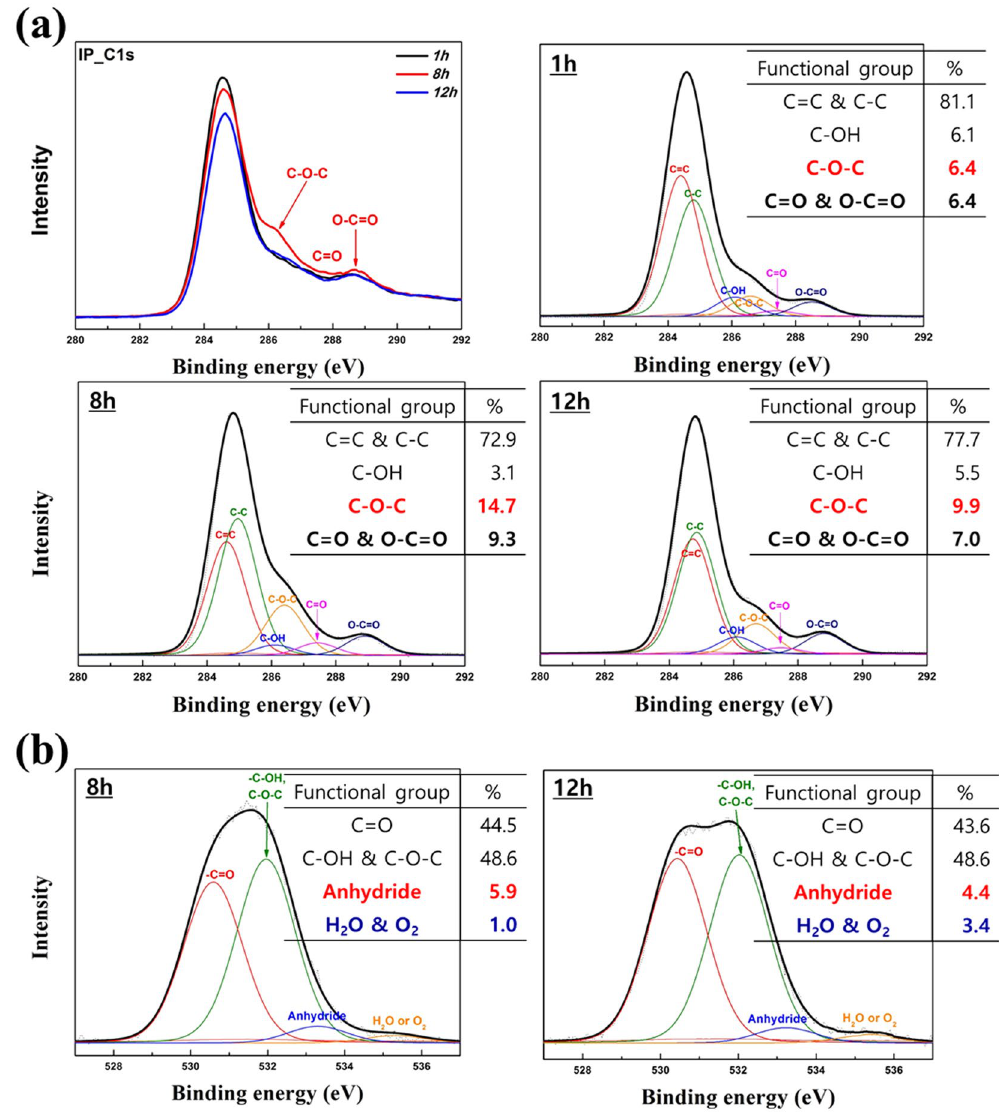
Figure 7. X-ray photoelectron spectra of IP OFs prepared with different oxidation times: ( a ) C1s and ( b ) O1s suggest that proper oxidation times create strong and necessary C-O bonds, whereas the overheating process used with the sIP12 OF generates unnecessary bonding between oxygens, diminishing the significant C-O bonding. It is determined that the O = O bond is lying on a site with weak thermal stability; therefore, the bonding site acts as a defect to destroy the crystal structure after carbonization. Due to the low oxygen content, the differ- ences in the molar ratio distributions of the sMP OFs are relatively lower than those of the sIP OFs (Figure S3). However, they reveal tendencies analogous to the analyzed results of the sIP OFs. Evidence for the weak thermal stability of the bonding between the carbon and oxygen molecules is provided by the thermal gravimetric results shown in Fig. 8(a). Assuming that the thermogravimetric process simulates the carbonization process, sIP12 and sMP12 OFs show greater degradation behavior in N 2 gas than the sIP8 and sMP8 OFs so, even though they contain similar oxygen content. In addition, Fourier transform infrared spectroscopy (FT-IR) results (Fig. 8b) strengthen our assertion from the XPS results. OFs prepared by two different pitches, IP and MP, showed similar tendency between appropriate and excess oxidation times, and it was confirmed that the over-oxidized OFs had stronger peaks at 1680 and 1630 cm − 1 , which indicate the bending vibration of water 39, 40 . Although the difference was not significant, weak -O-O- bonds of OF 12 h including peroxide group were also slightly greater than those of OF 8 h. The FT-IR results support the idea that the over-oxidized OFs have more oxygen atoms; however, the over-oxidized OFs exhibit lower mechanical properties because they retain more weak oxygen bonds thermally.